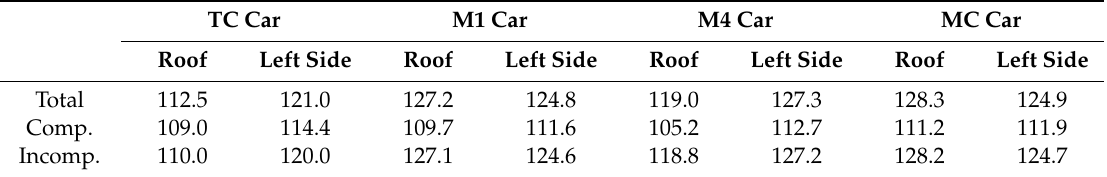
Table 4. Estimated overall power spectral density levels for each pressure field; unit: